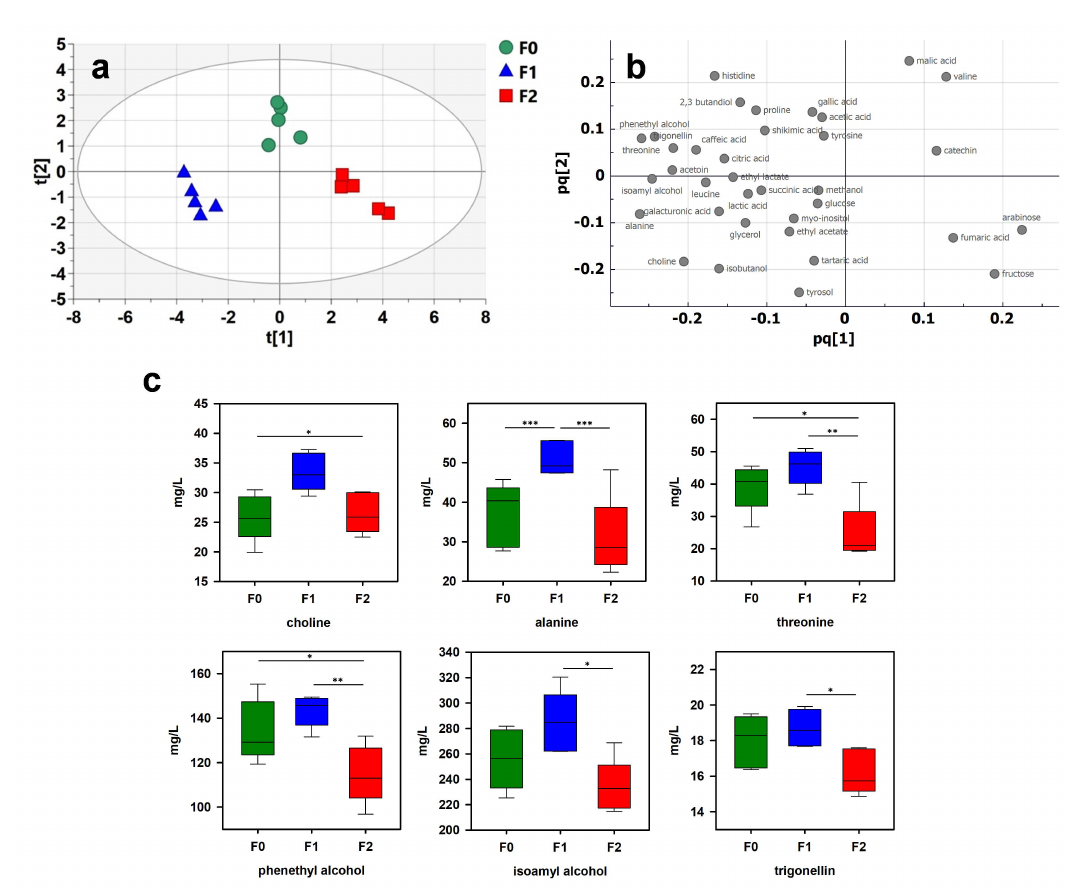
Figure 4. Multivariate analysis of 1 H-NMR spectra of wine samples treated by different finings (F0: untreated; F1: fining 1; F2: fining 2): ( a ) OPLS-DA score plot; ( b ) loading plot; ( c ) boxplots of 6 most discriminant wine constituents (t[1] and t[2]: first and second predictive components; pq[1] and pq[2]: first and second predictive component loadings). The significance in the difference was calculated by ANOVA followed by Tukey’s multiple comparison test (indicated as * p < 0.05, ** p < 0.01, *** p <